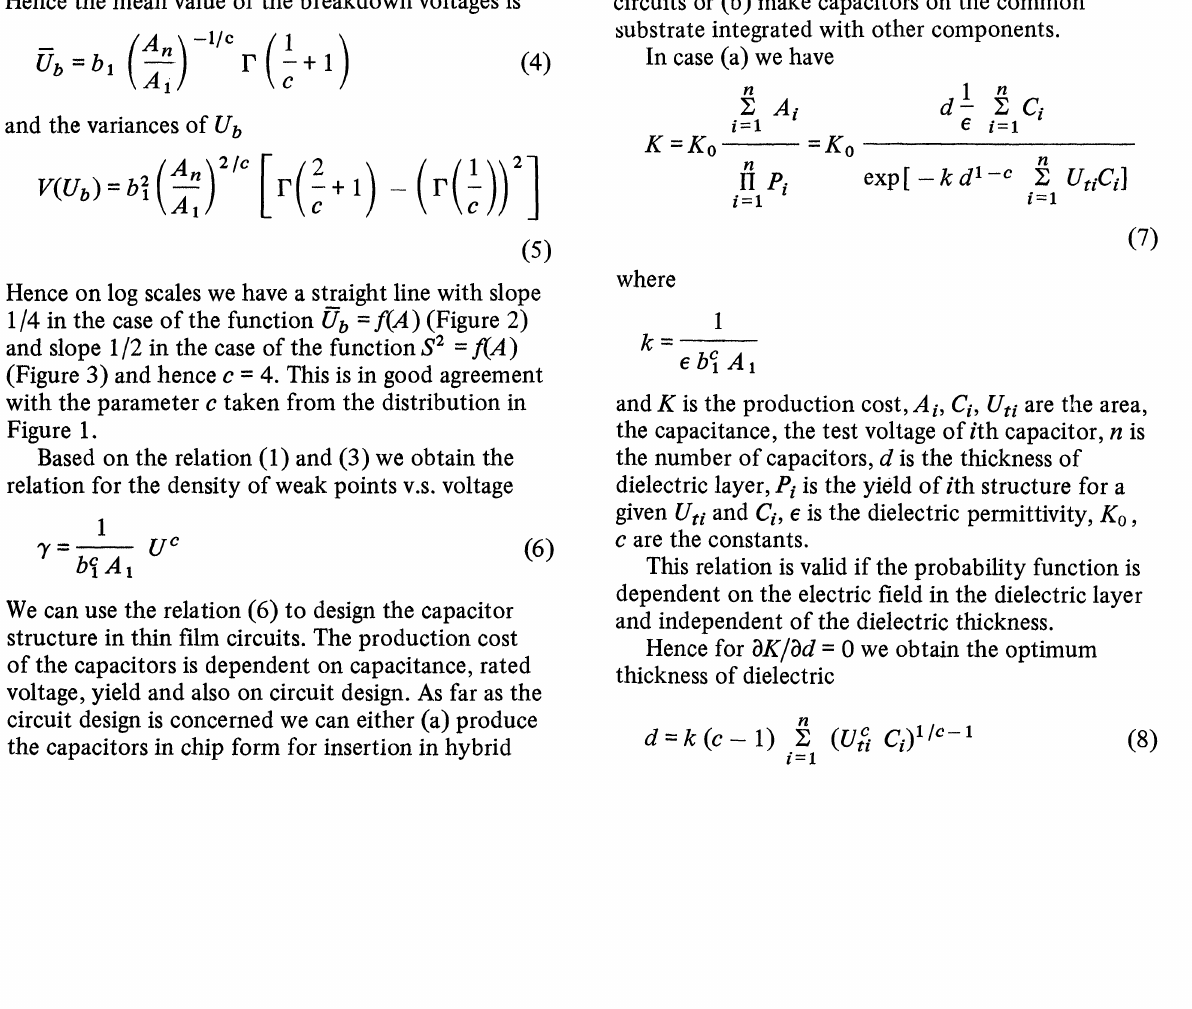
FIGURE 3 Change in the mean square deviation v.s. the capacitor area.